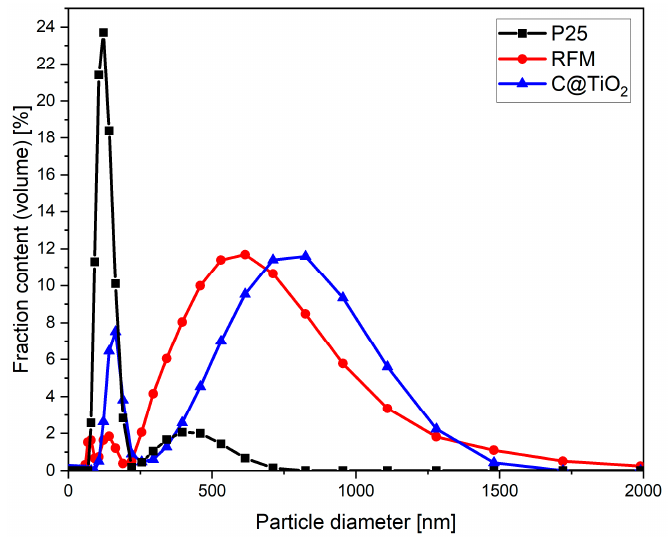
Figure 1. DLS measurements of particle size dispersion of commercial P25, RFM template, and C@TiO 2 .